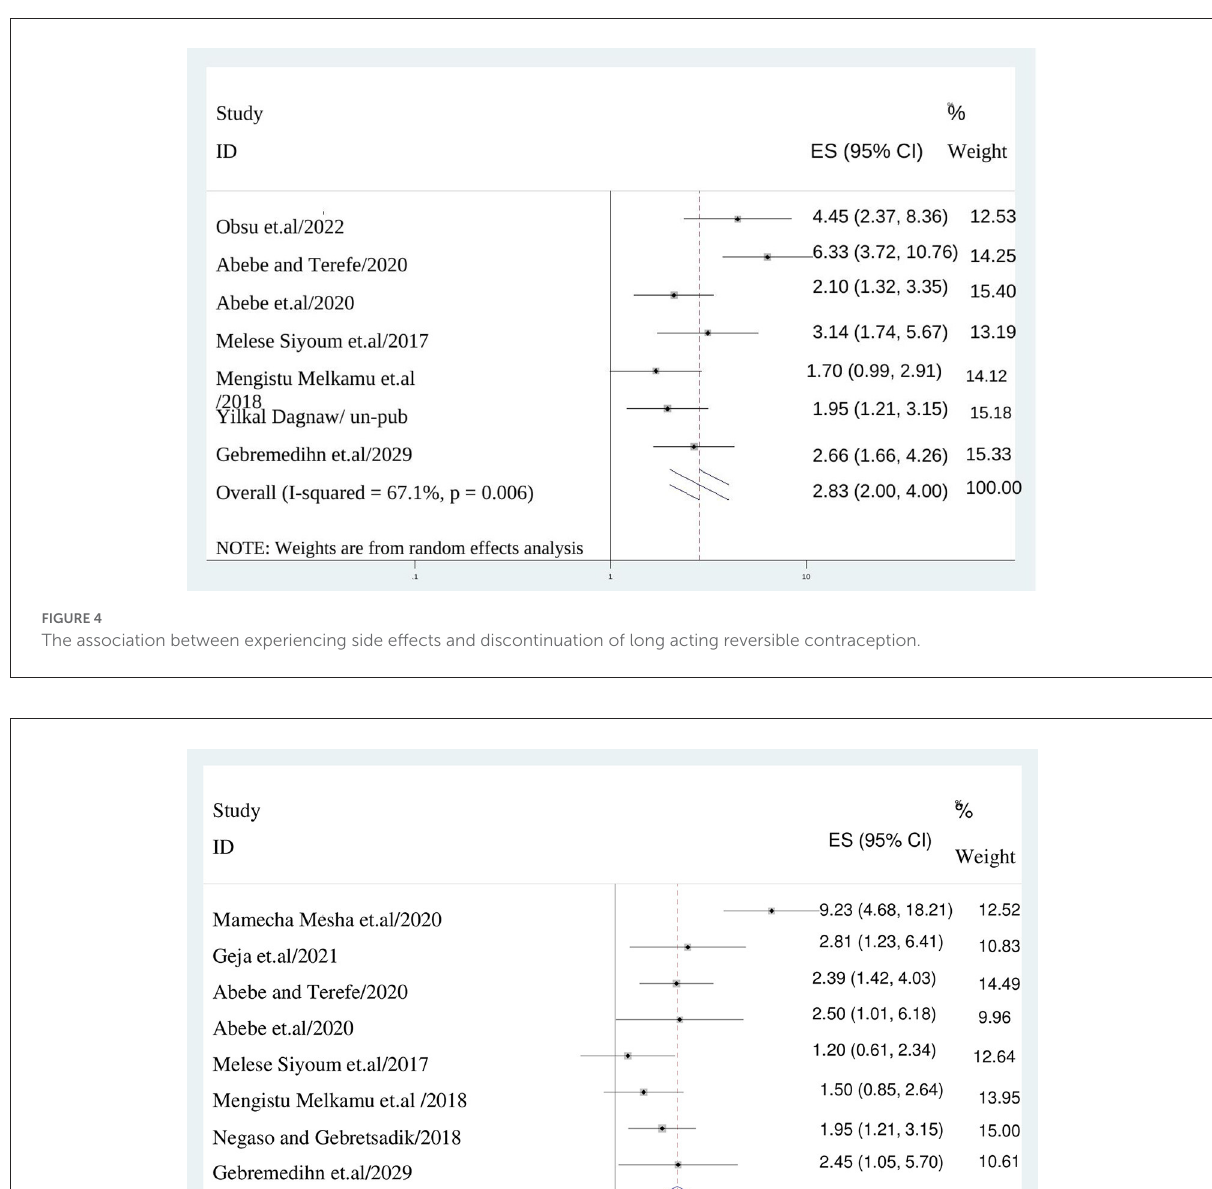
Sub-group analysis was done based on study region, setting, design, year of insertion and reason of discontinuation of long acting contraceptive methods. As a result, the Amhara region had a higher rate of contraceptive discontinuation (45%) than the Oromia region (35.6%). This could be due to regional socio-cultural and awareness differences.